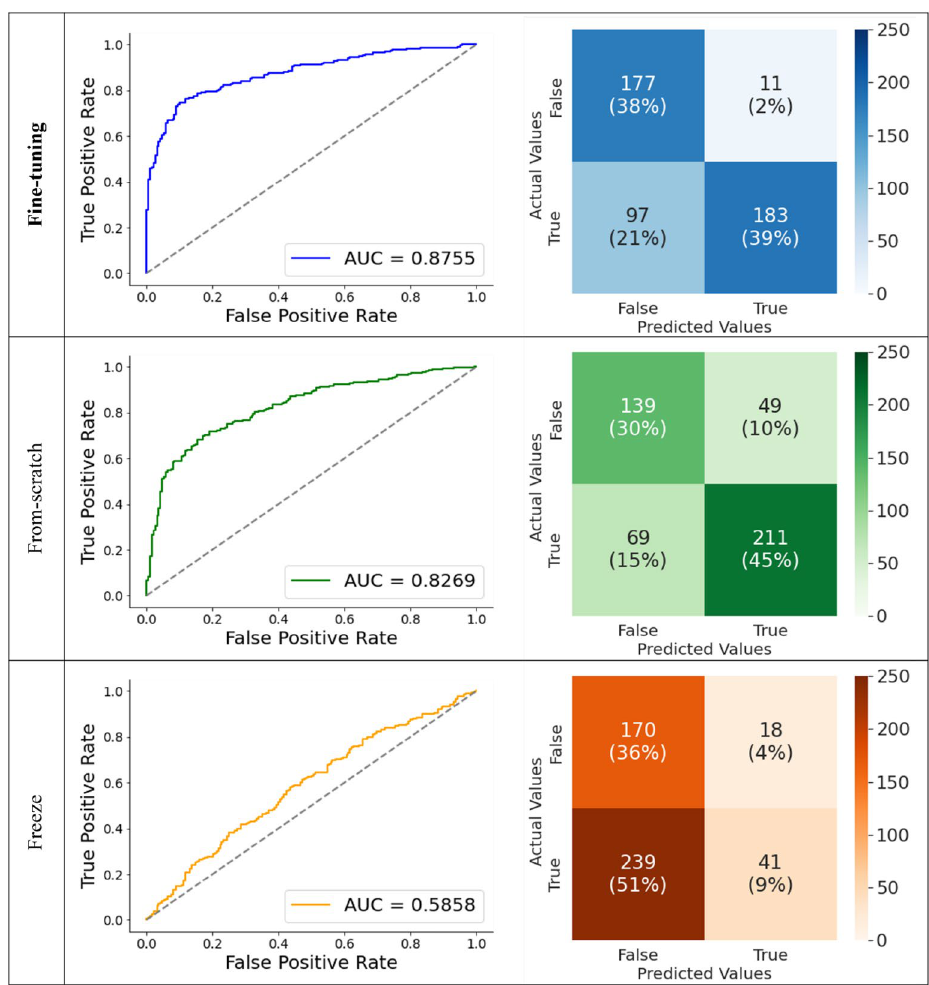
Figure 4. Classification results of three convolutional neural network (CNN) models using different learning strategies. Fine-tuning (blue), from-scratch (green), and freeze (orange). The fine-tuning model outperforms the others (area under the curve [AUC] =